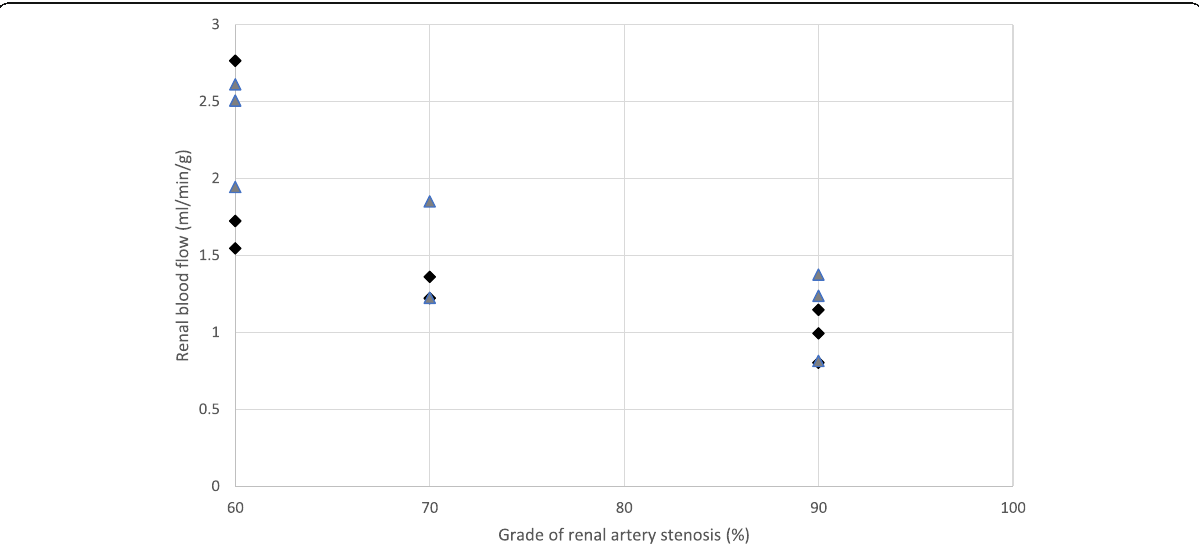
Fig. 1 Grade of renal artery stenosis vs renal blood flow in unilateral RAS. ♦ Grade of renal artery stenosis vs basal flow in unilateral RAS ( r = 0.8, p = 0.04). Grade of renal artery stenosis vs stress flow in unilateral RAS ( r = 0.8, p =